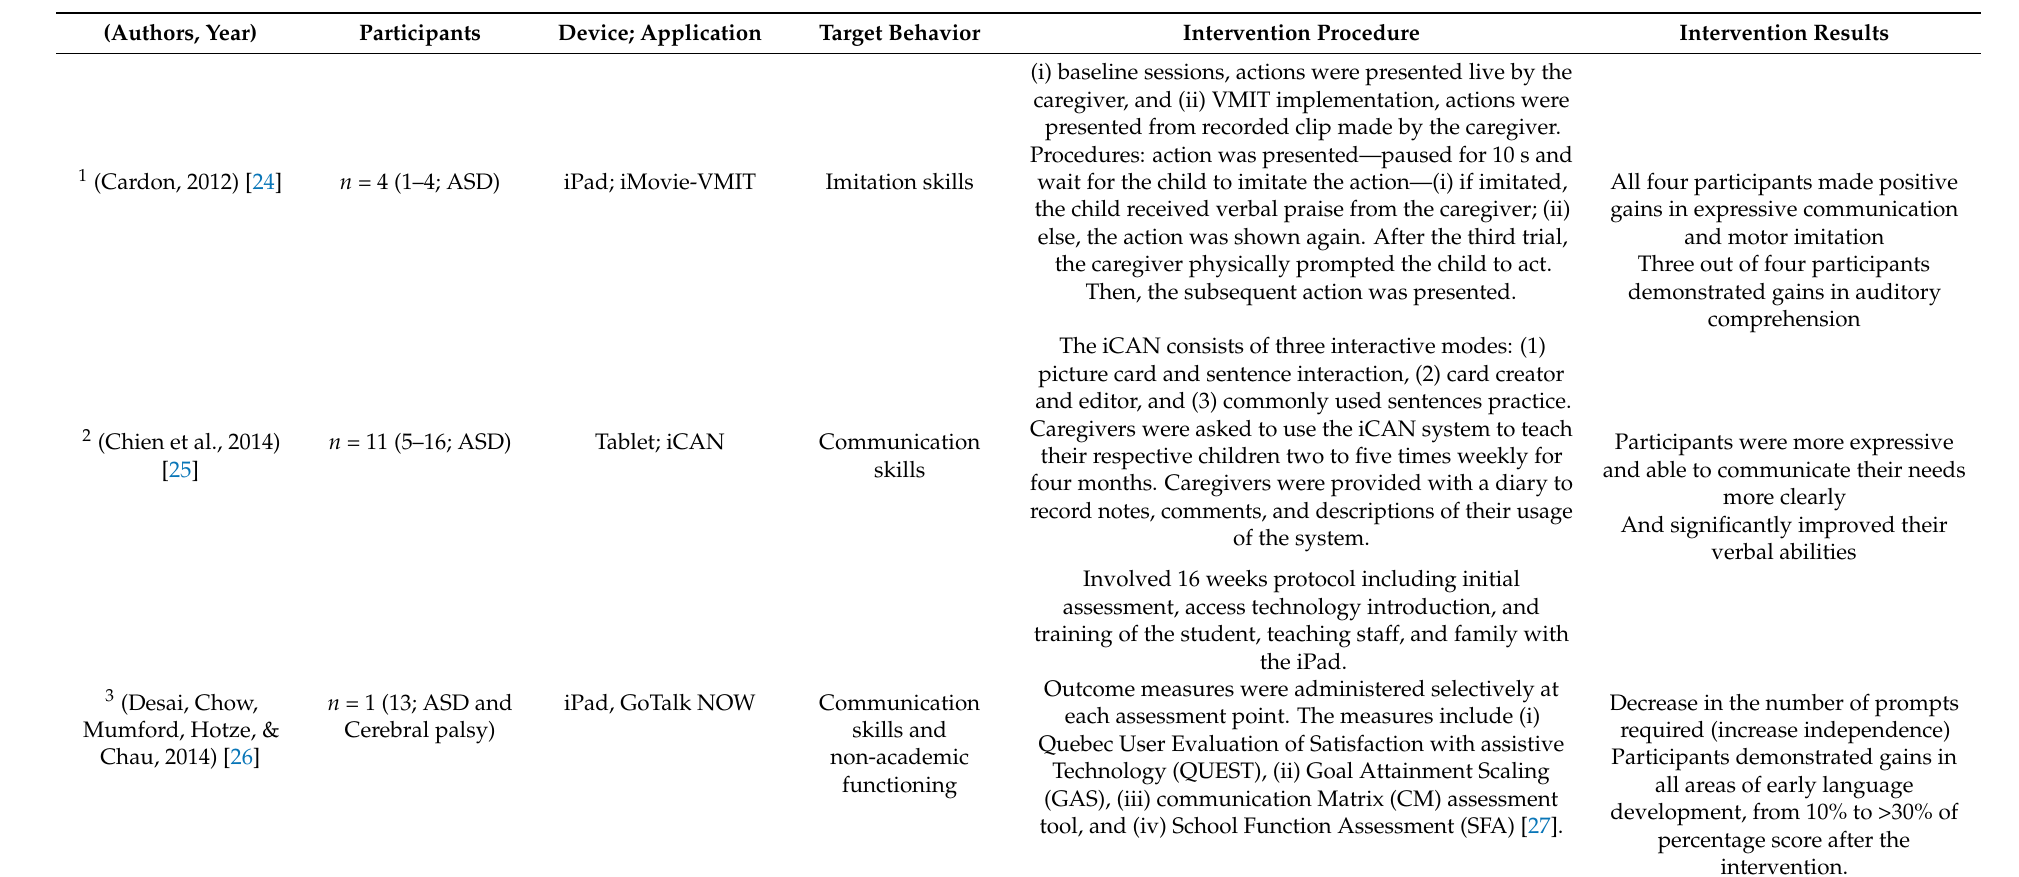
Table A1. Summary of research articles; n(x; y) = number of participants (Age in years;